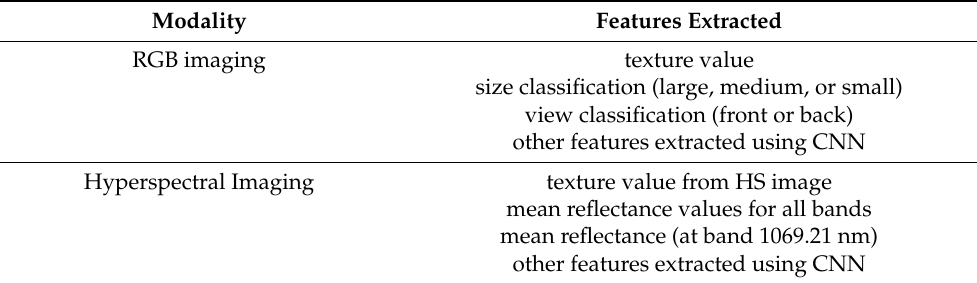
Table 3. Summary of features extracted from RGB and Hyperspectral